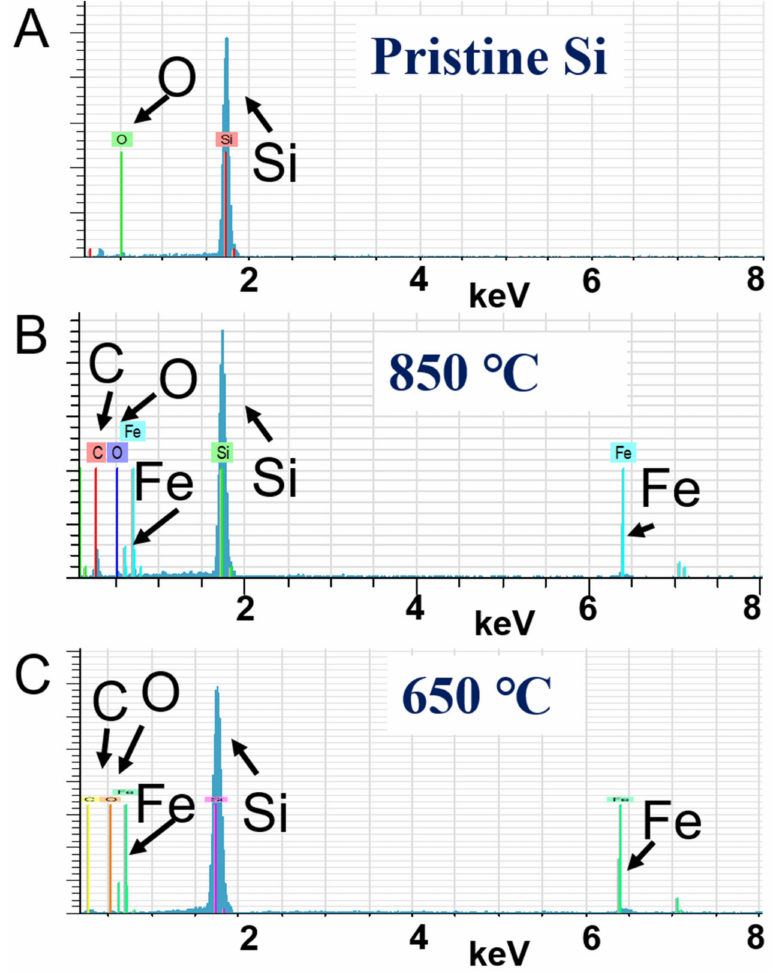
Figure 8. EDAX spectra of ( A ) as-received silicon flakes and those coated by CNTs and nanocarbons, using ferrocene and camphor in water vapor at ( B ) 850 ◦ C and ( C ) 650 ◦